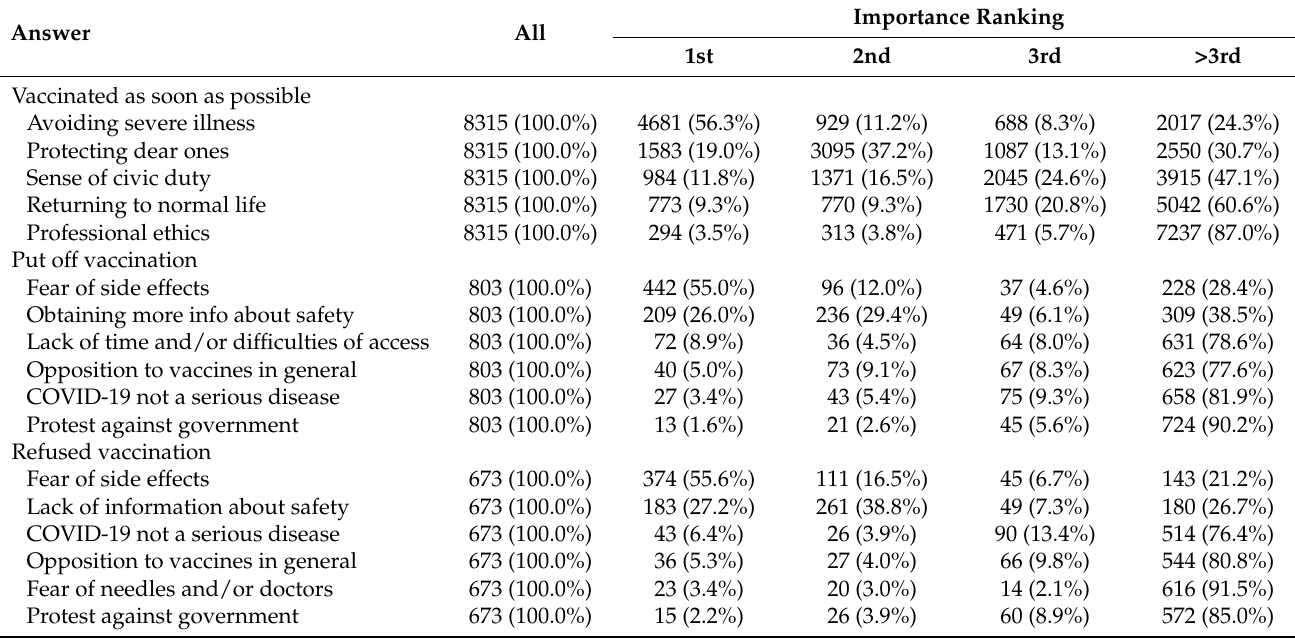
Table 4. Reasons for receiving COVID-19 vaccination as soon as possible, putting off getting vacci- nated, and refusing vaccination. Counts and percentages were obtained by weighting all observed values with post-stratification weights based on the distribution of Italy’s resident adult population by NUTS region, gender, and age